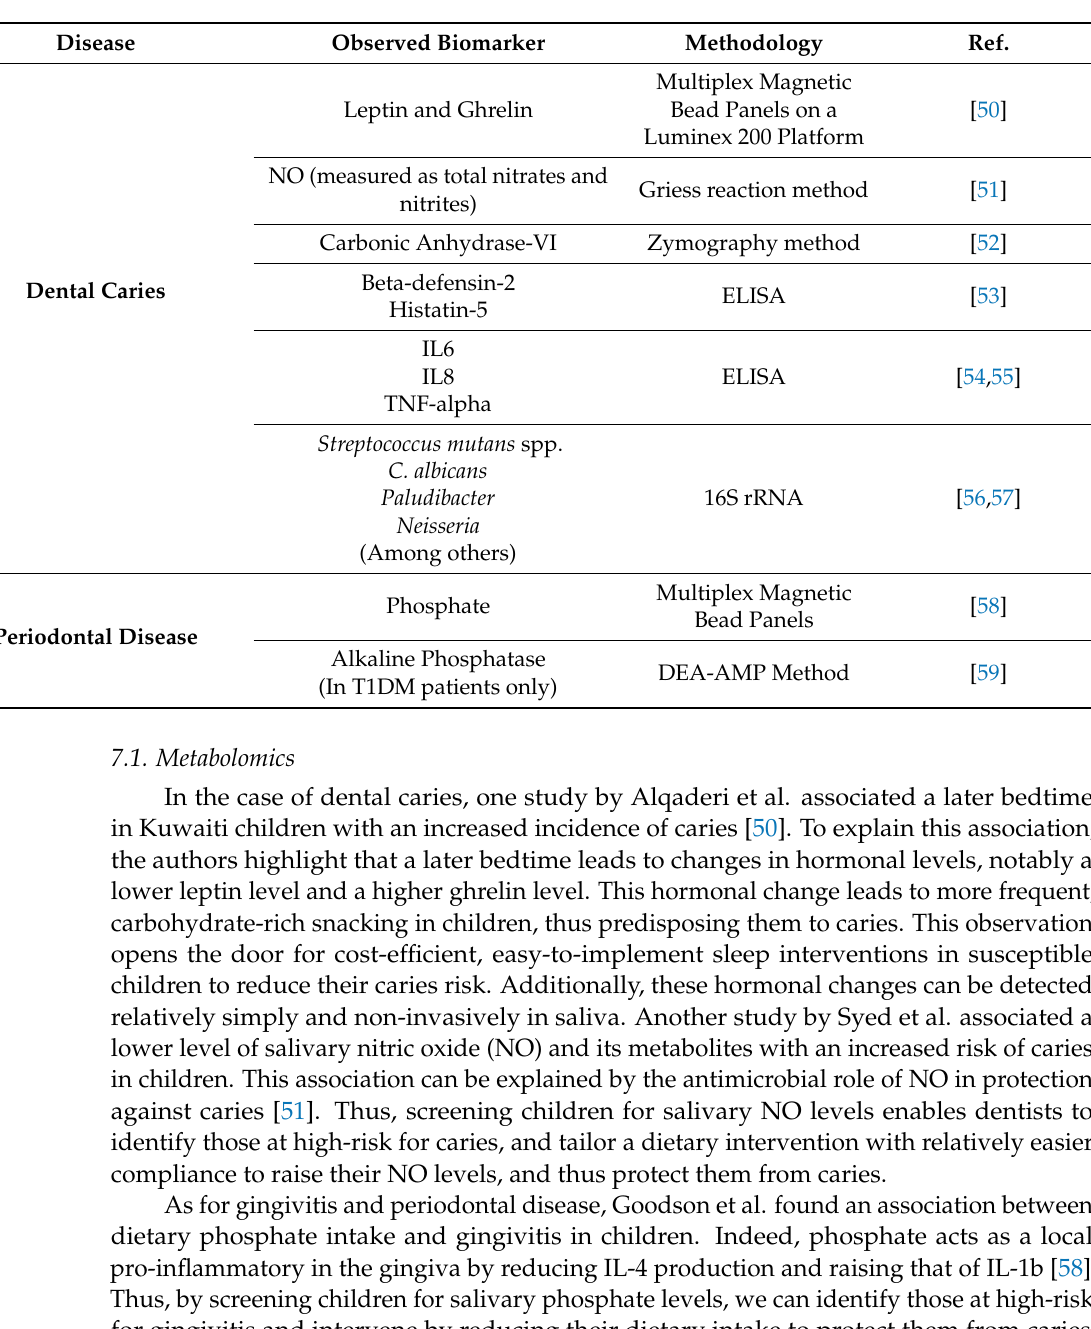
Table 5. Oral diseases and their respective studied